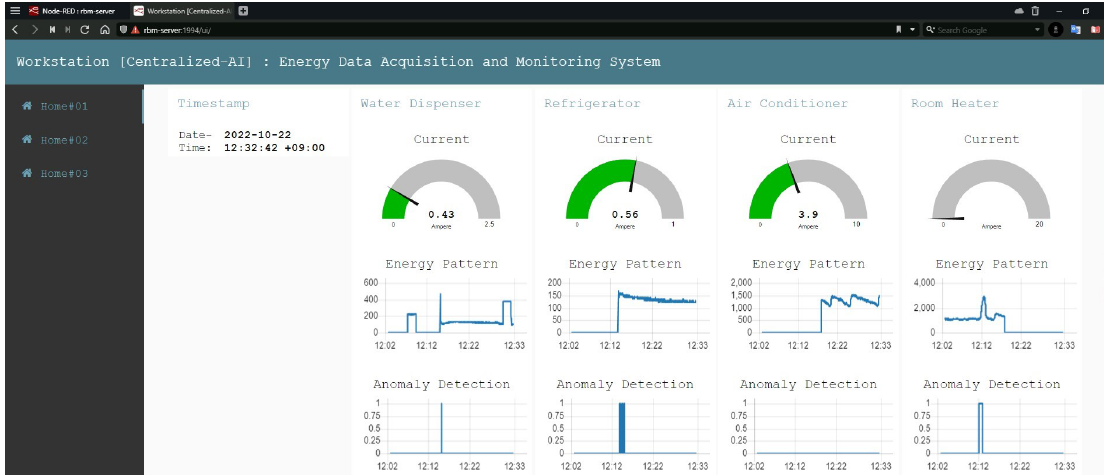
Figure 19. Monitoring individual house data in the edge dashboards.